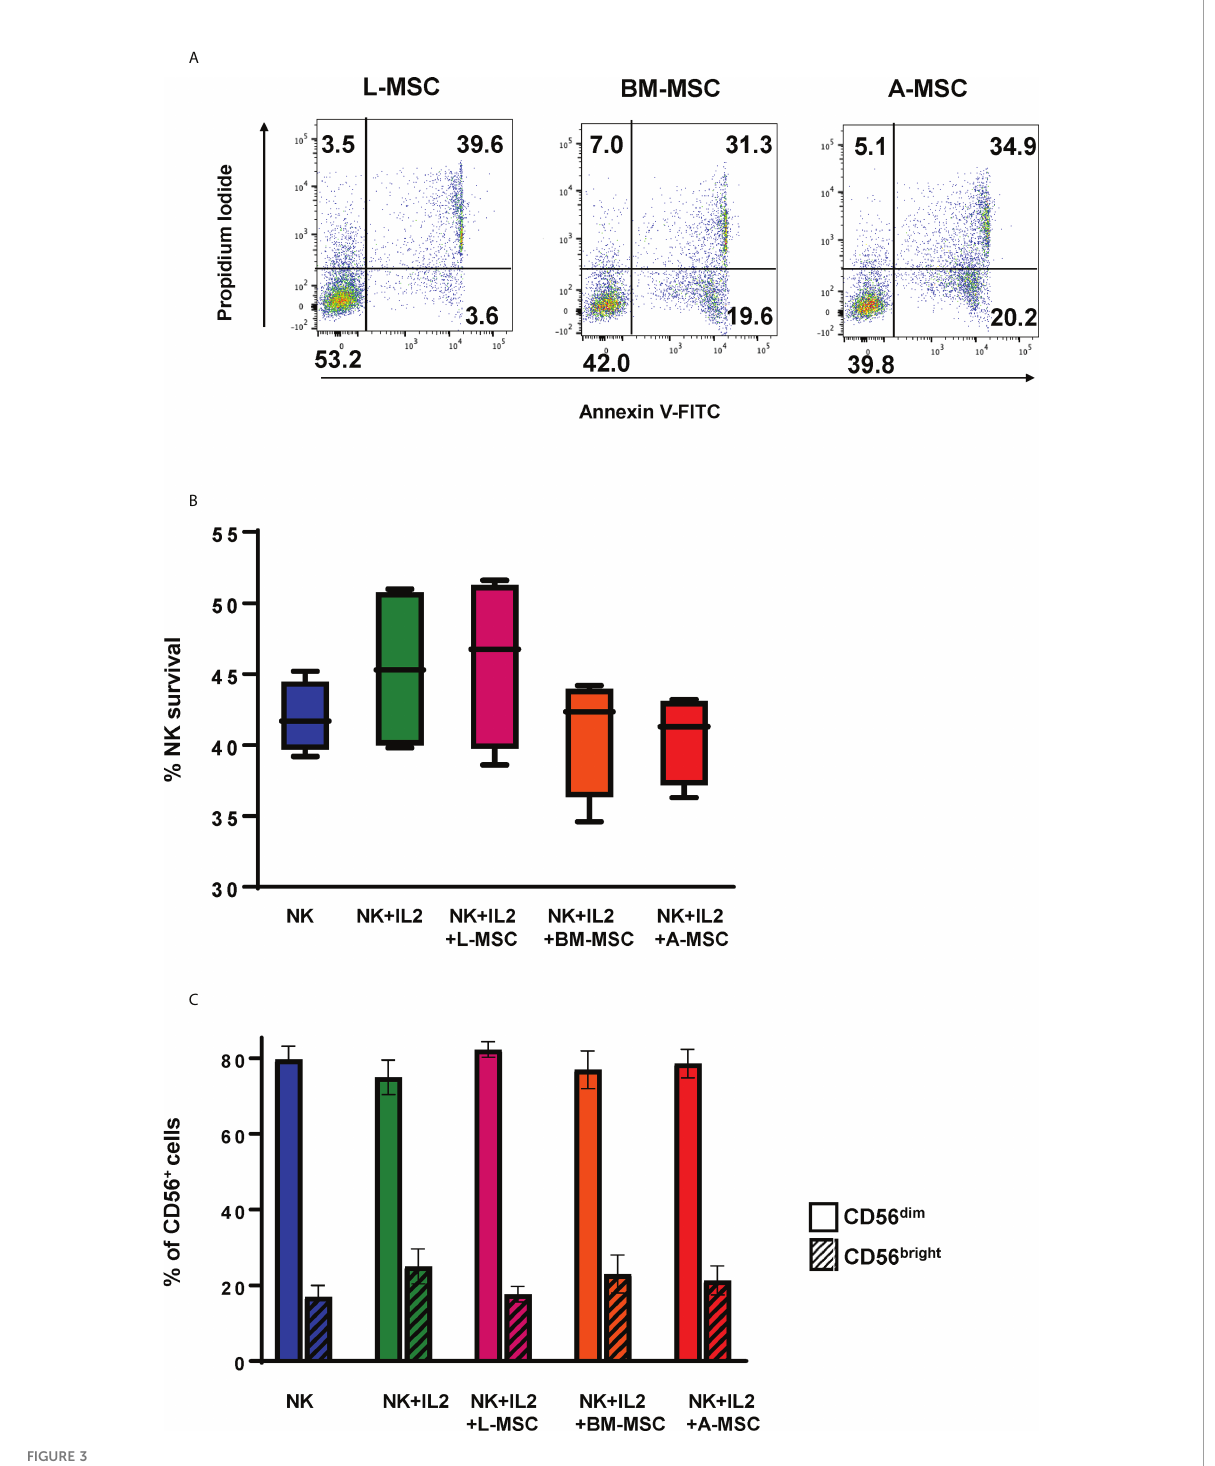
FIGURE 3 Survival of the NK cells and their subset differentiation after co-culturing with MSC. NK cells were co-cultured with MSC for 3 days (with 100 U/ ml rhIL-2), and their survival analyzed by both Annexin V/Propidium Iodide dual staining (A) and trypan blue dye exclusion (B) . No difference was observed in NK cell survival between the different MSC co-cultures. Data presented in panel A is representative of 4 independent experiments. Data presented in panel B represents mean percent viable NK cells ± SD of 5 independent experiments, analyzed by Student ’ s pair t-test. (C) The phenotype of NK cells was assessed by fl ow cytometry after co-cultures with MSCs for 3 days. Percentages of CD56 bright and CD56 dim are shown from 3 different experiments with mean values ± SD. Data were analyzed using Student ’ s pair t-test. L-MSC, liver mesenchymal stromal cell; BM-MSC, bone marrow mesenchymal stromal cell; A-MSC, adipose mesenchymal stromal cell; NK, natural